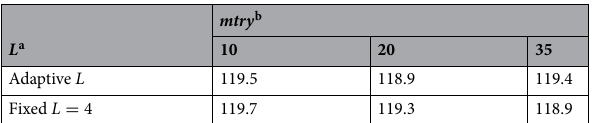
Table 4. The prediction error obtained from the fivefold cross-validation under six combinations of the two a tuning parameters. L is the number of functional PCs to be retained in Eq. (3). of the predictors that are considered at each split.